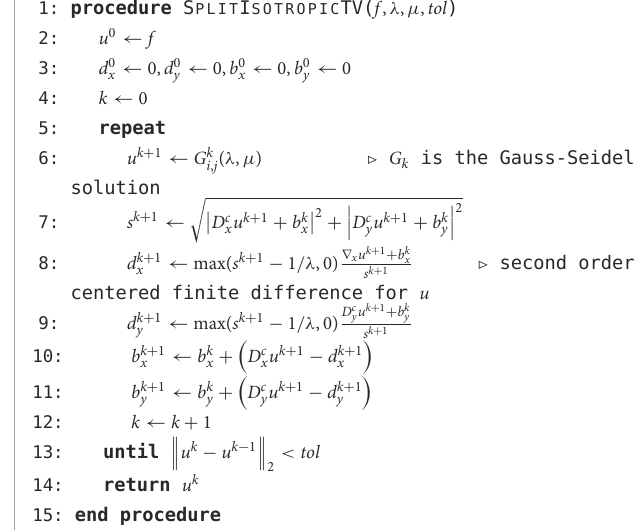
Algorithm 1. Implemented split Bregman isotropic TV